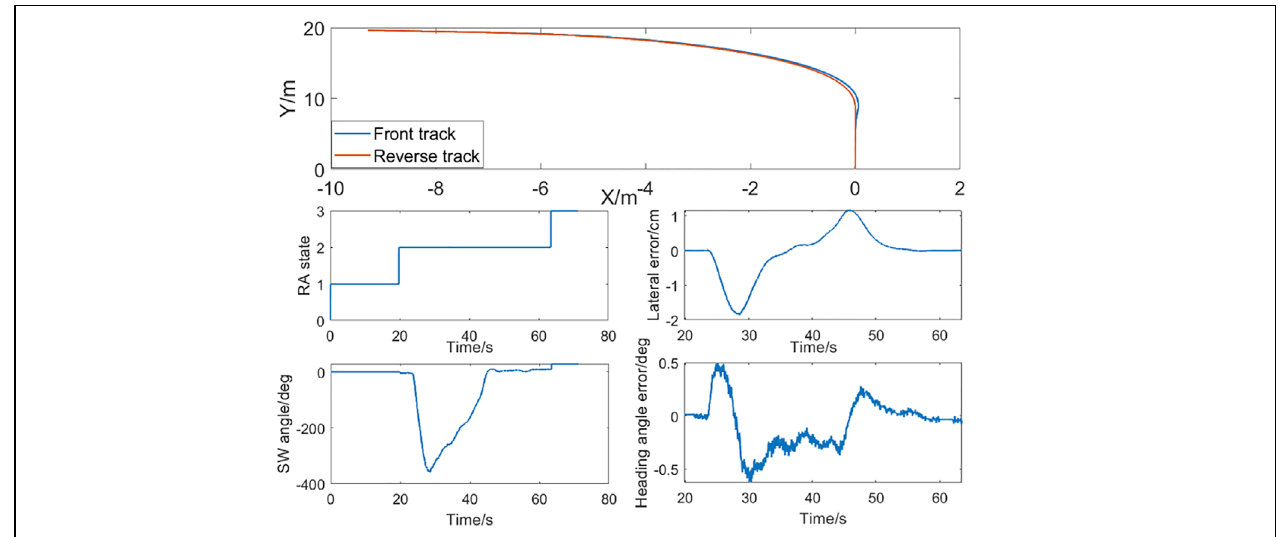
FIGURE 11 | RA in right-angle bending condition.